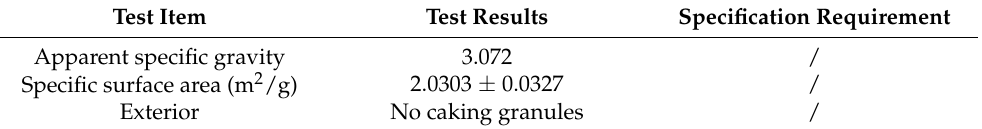
Table 6. Physical properties of Cement.